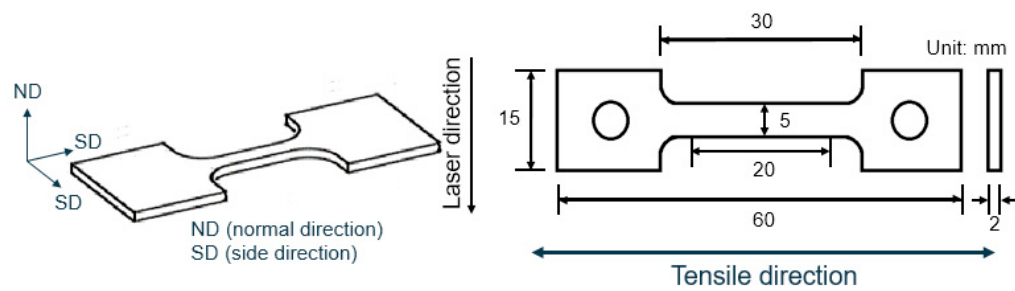
Figure 4. Schematic diagram of the selective laser melting (SLM) IN718 tensile specimen.